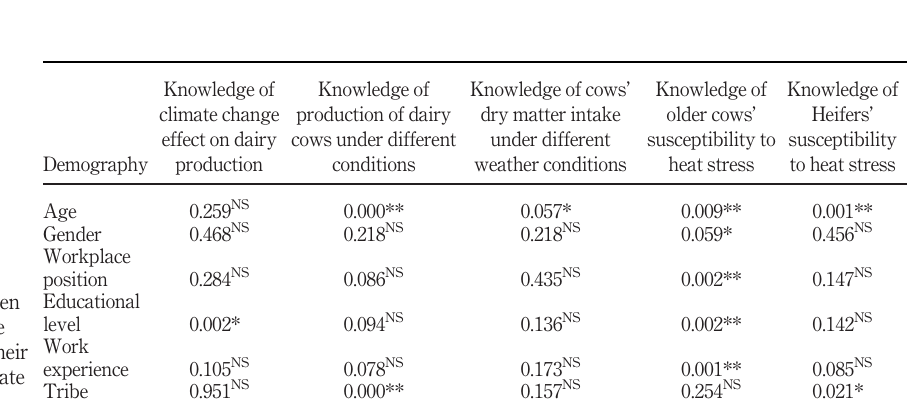
Table 5. Association between demography of the participants and their knowledge of climate change and heat